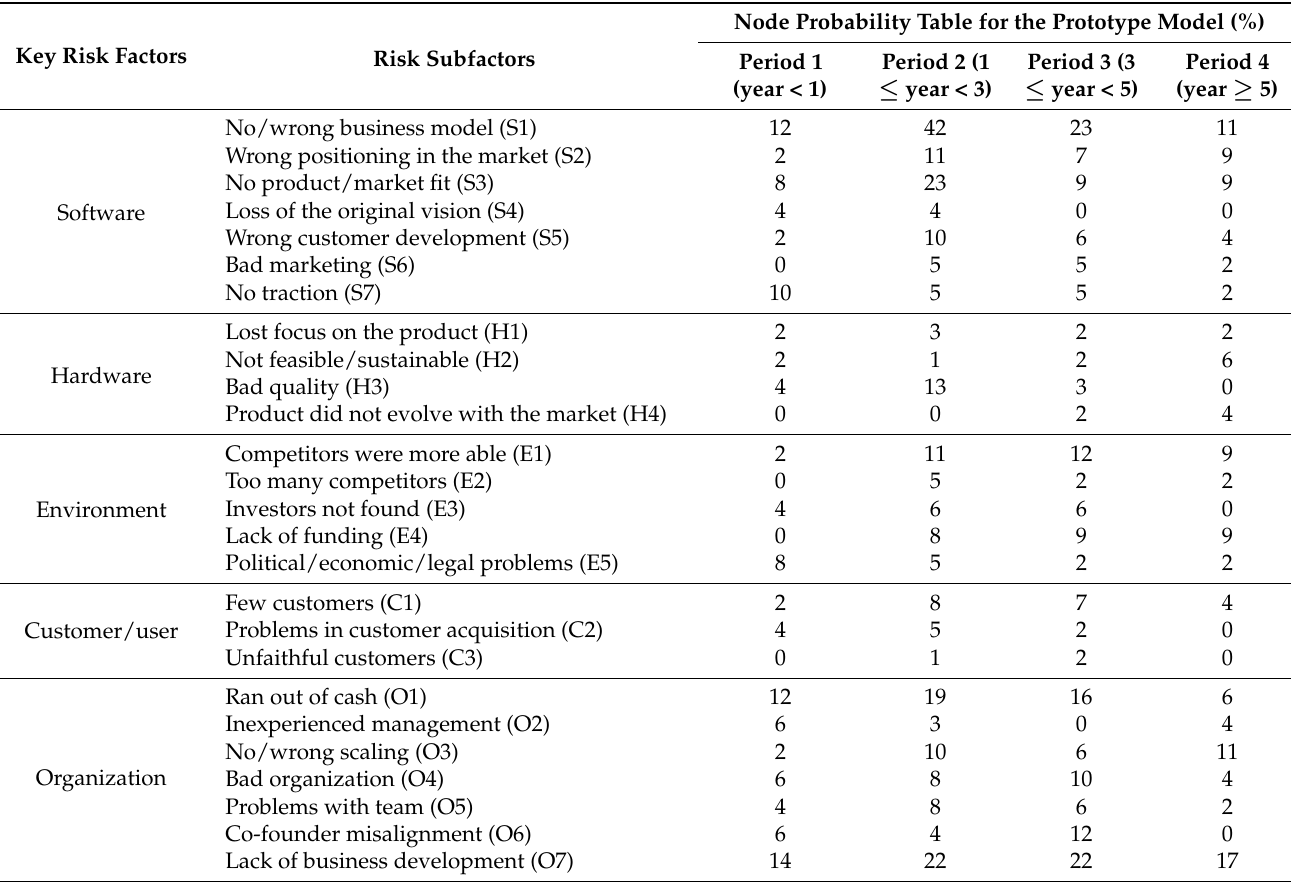
Table A1. Summary of data for elicitation of NPT for the prototype